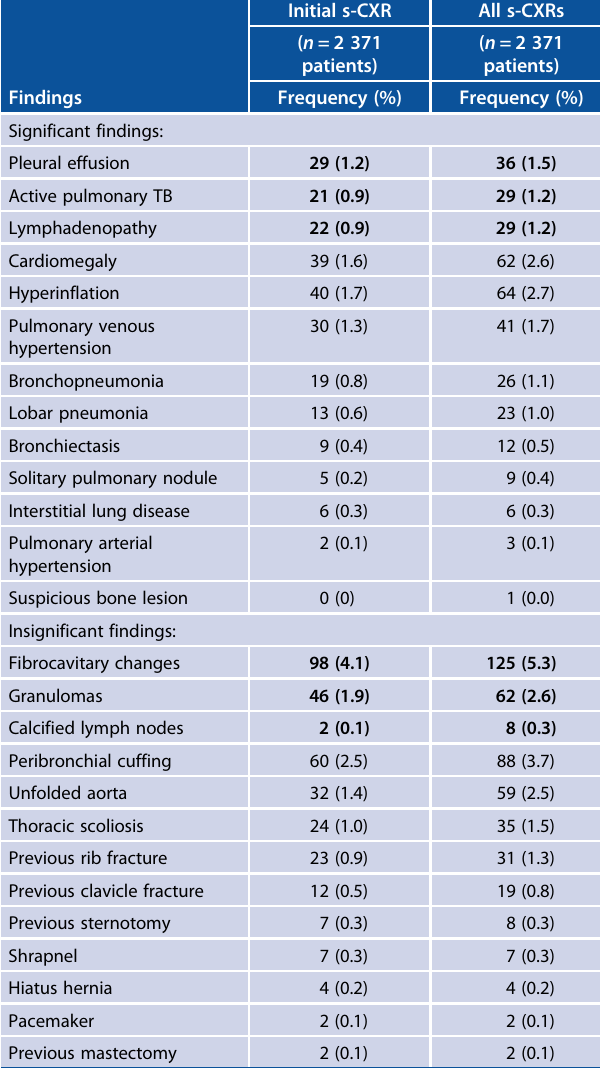
Table 1: Summary of findings on s-CXRs during the study